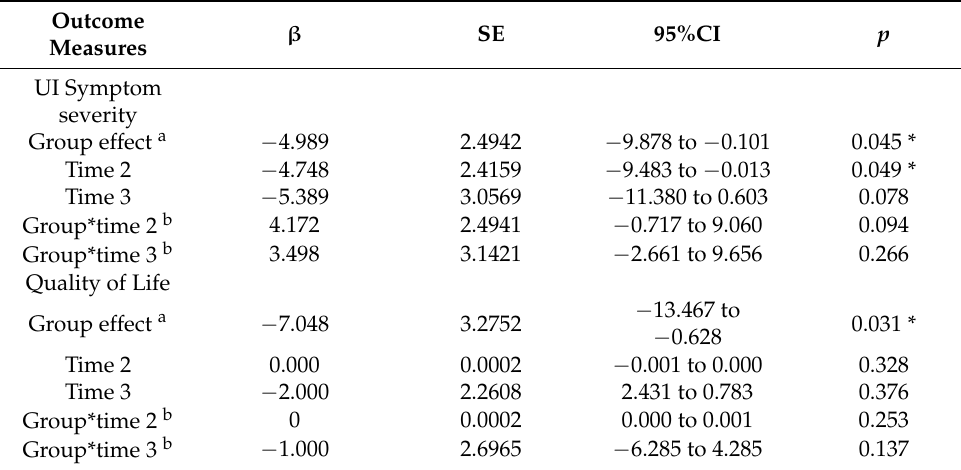
Table 7. The effect of KEPT app on urinary incontinence and quality of